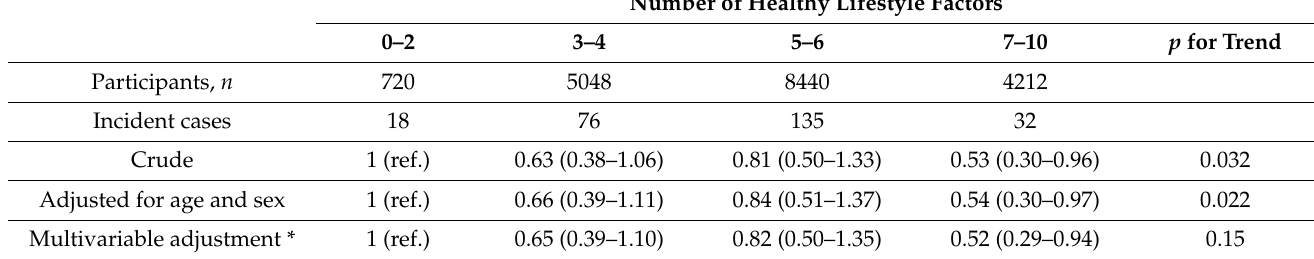
Table 2. Glaucoma risk at 10-year follow-up, according to number of healthy lifestyle factors. (The SUN